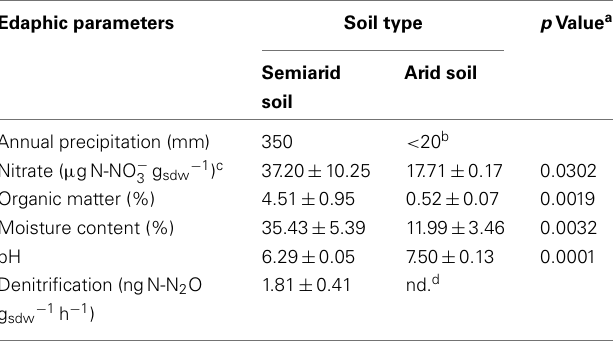
Table 1 | Comparison of the edaphic parameters and denitrification activity for the two soil